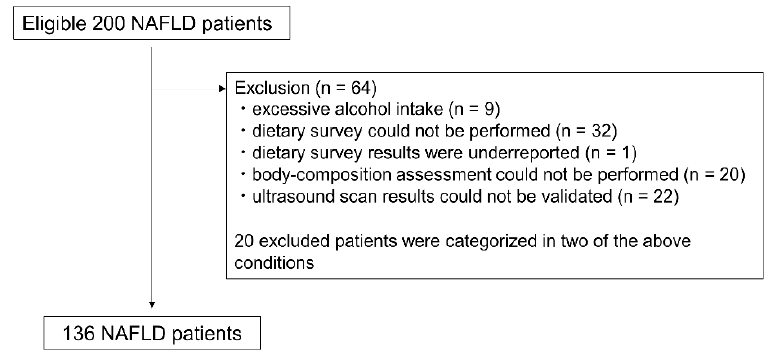
Figure 1. Study subject flowchart. NAFLD: Nonalcoholic fatty liver disease .